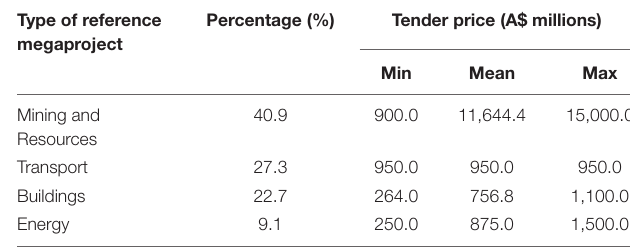
TABLE 5 | Profile of reference megaprojects by type.